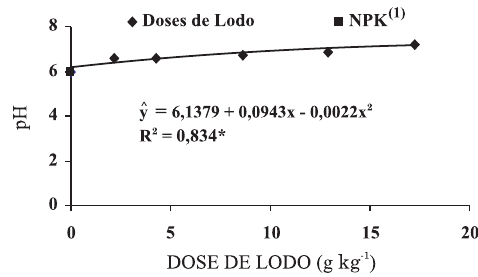
Figura 1. Variação do pH do solo após a aplicação de doses crescentes de lodo anaeróbio da estação de tratamento de efluentes de parboilização de arroz. (1) Tratamento NPK incluído como referência fora da análise